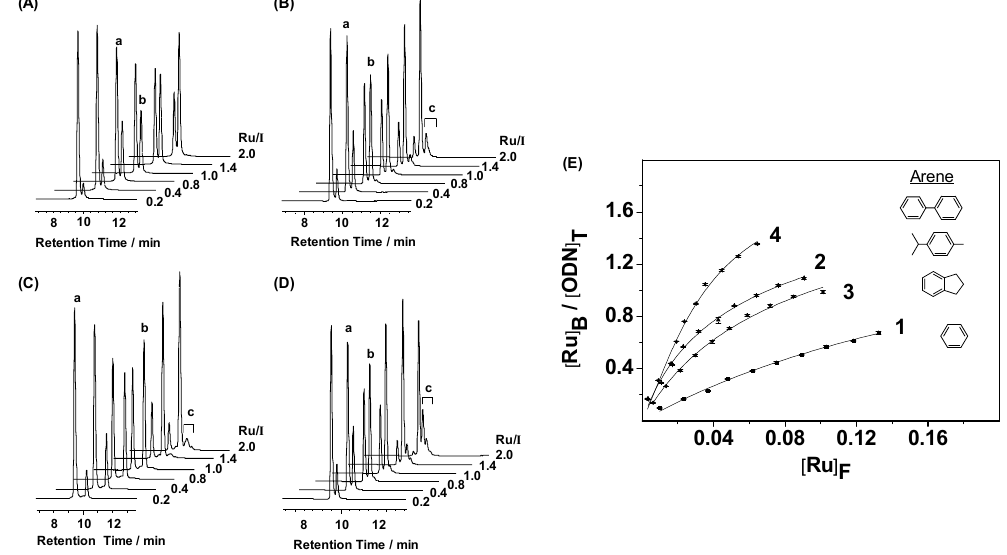
Figure 2. ( A – D ) HPLC chromatograms for reaction mixtures of complex 1 ( A ), 2 ( B ), 3 ( C ), or 4 ( D ) with single strand I (0.1 mM) at various molar ratios in 50 mM TEAA at 310 K for 24 h. Peak assignments: a, unruthenated strand I ; b, mono-ruthenated I ; c, di-ruthenated I . ( E ) A direct plot (dots) of moles of ODN-bound 1 , 2 , 3 , or 4 ([Ru] B ) as a function of the concentration of free ruthenium complexes ([Ru] F ). Computer-fitting (lines) of the experimental data to the ligand–receptor binding Equation (8) (see details in Supplementary Materials) gave rise to the equilibrium constants for the two-site binding reactions listed in Table 2.